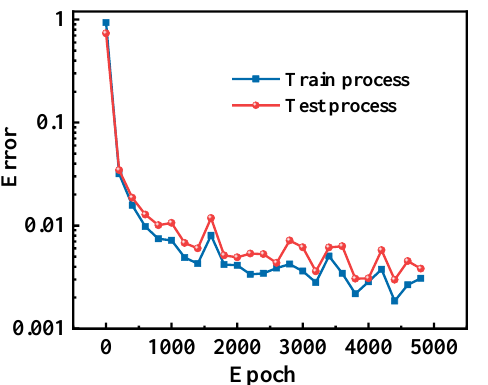
Figure 5. Off-state I – V curve prediction error changes corresponding to different training epochs.